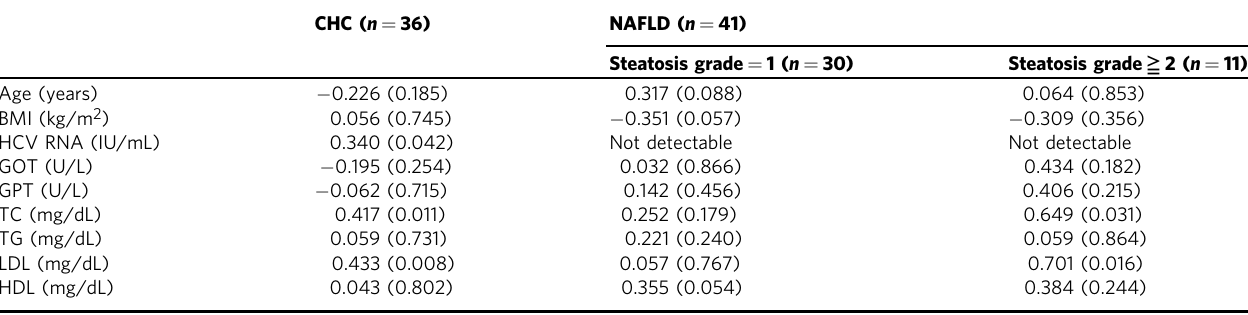
Table 1 The correlation between circulating ApoJ and analytical components in CHC and NAFLD patient